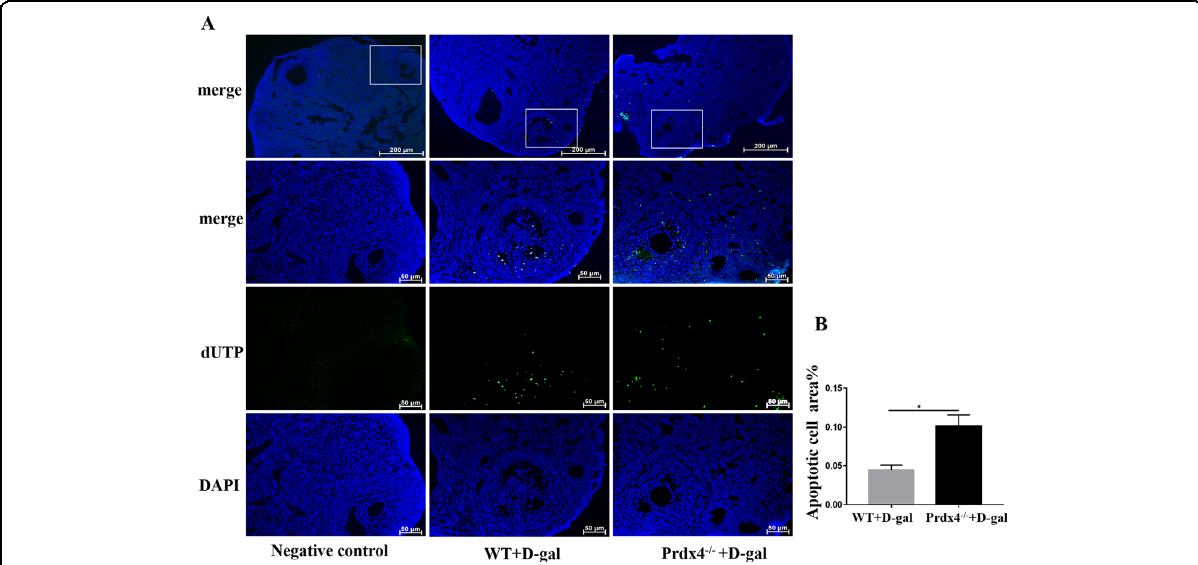
Fig. 3 Increased ovarian cell apoptosis in Prdx4 − / − mice. a Apoptosis was analysed using an in situ TUNEL fl uorescence assay (×20). In the TUNEL assay, nuclei of TUNEL-positive (apoptotic) cells were stained green. b The number of TUNEL-positive granulosa cells was compared between the two groups. Scale bars = 200 μ m at ×10 magni fi cation; scale bar = 50 μ m at ×20 magni fi cation. All data are shown as means ± SEMs, n = 5. Statistical signi fi cance: * P <